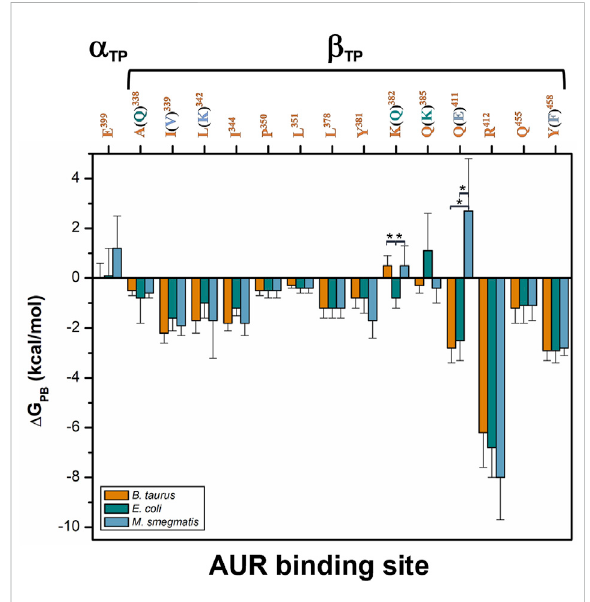
FIGURE 9 Per-residue free energy comparison of the AUR binding site of bovine and two pathogen species. The numbers correspond to BtF1. Residue variations relative to BtF 1 are in parentheses. Residues with statistically signi fi cant energy differences ( α < 0.05) according to a Student-t distribution are marked with